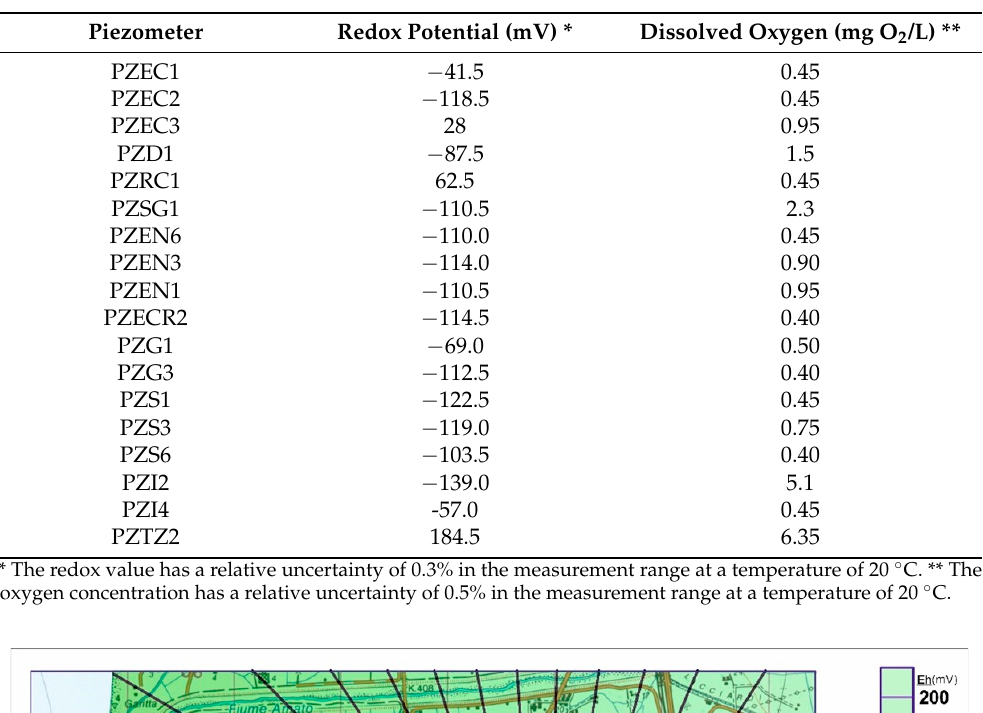
Table 2. Redox Potential and Dissolved Oxygen—Median Values [6].